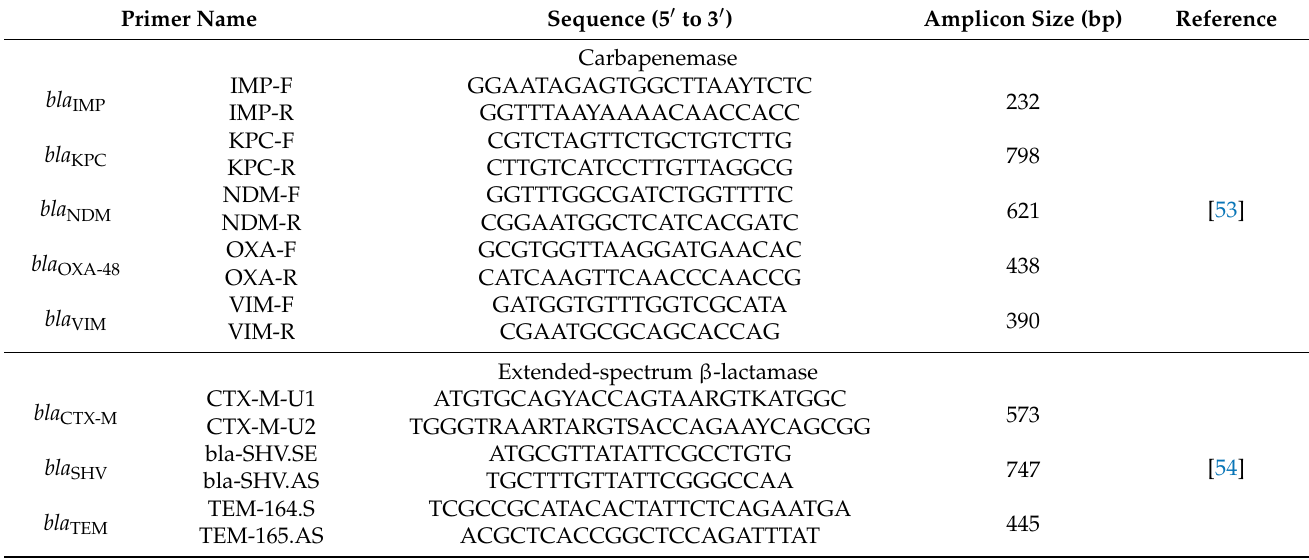
Table 3. Primers used for PCR amplification of carbapenemase and ESBL